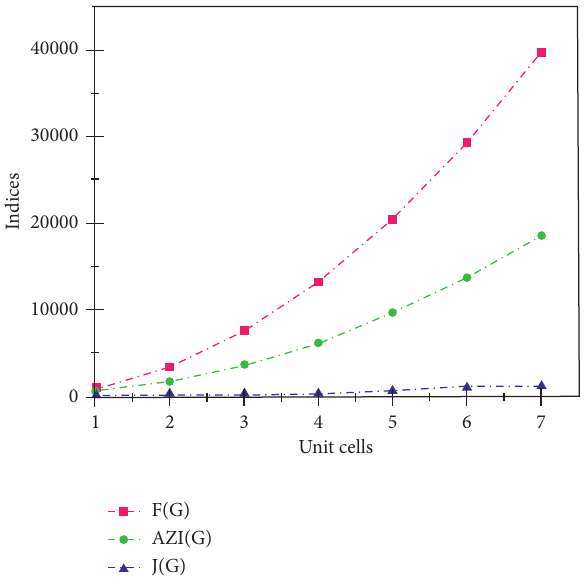
( G ) , PM ( G ) indices vs. unit cell. 1 2